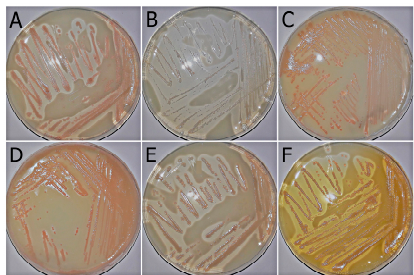
Figure 3. Growth of tested strains on GC agar medium. ( A ) Asaia bogorensis ISD1; ( B ) A. bogorensis ISD2; ( C ) A. bogorensis FFMW; ( D ) Asaia lannensis IFCW; ( E ) A. lannensis FMW1; ( F ) A. lannensis W4. Under the influence of the produced organic acids, the color of the medium is changed from